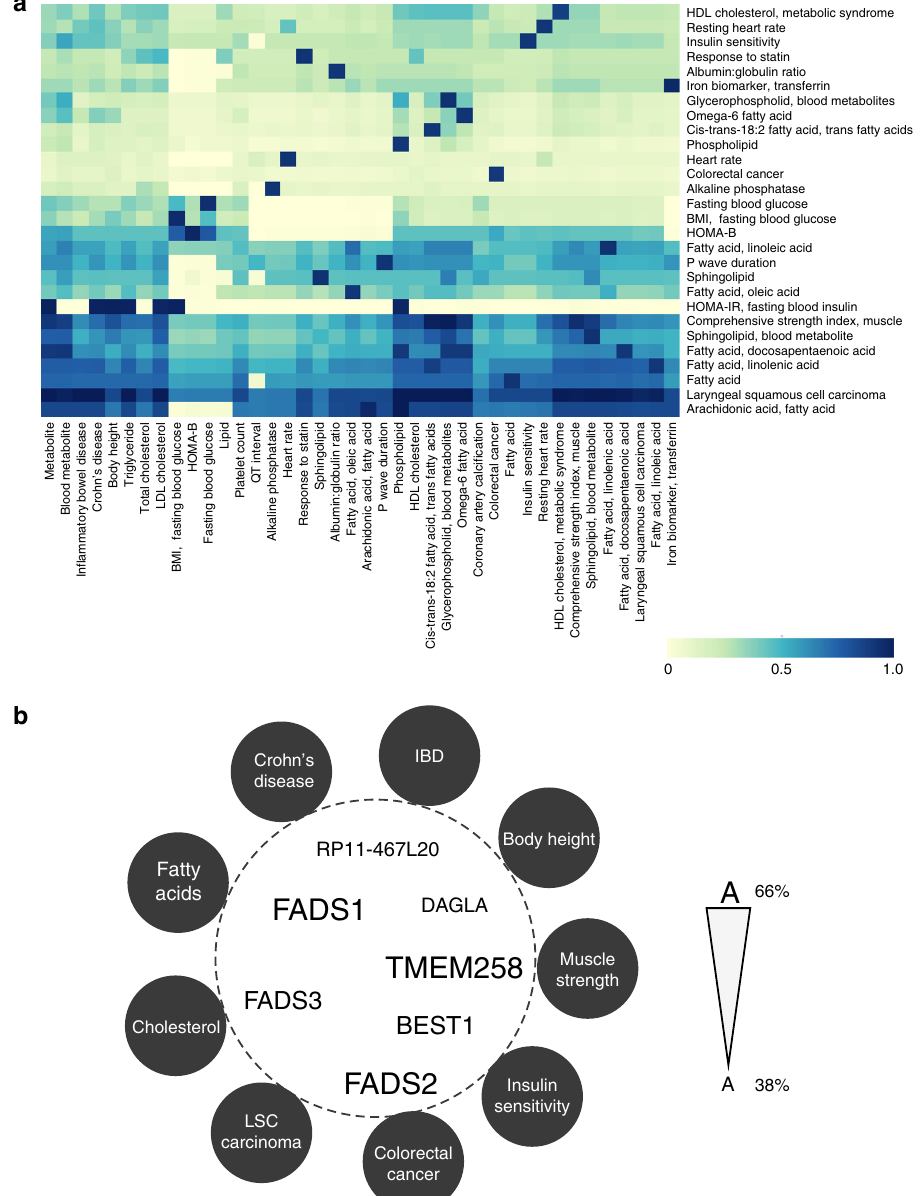
Fig. 2 The largest cluster comprises 40 phenotypes related to fat metabolism. a SNPs associated with in fl ammatory bowel disease, cholesterol levels, insulin sensitivity, muscle strength index and laryngeal squamous cell carcinoma, amongst others, are associated with transcription effects at a pool of shared spatial eGenes. Deep blue squares indicate higher proportions of shared eGenes, with 1 being the highest and indicating that two phenotypes have the same set of eGenes. b The FADS locus on chromosome 11 is responsible for the identi fi ed interrelationships (i.e. the multimorbidity) between the phenotypes in this cluster. We hypothesise that the interrelationships between the additional 2431 spatial eGenes that are associated with these multimorbid phenotypes contribute to the unique characteristics and sub-clustering of the phenotypes (Supplementary Data 4). In this word cloud, the size of a gene name represent the percentage of phenotypes whose associated variants spatially affect the expression of that gene in the cluster e.g. the expression of FADS1 , FADS2 and TMEM258 are associated with eQTLs in 26 of the 40 phenotypes in the cluster (Supplementary Data